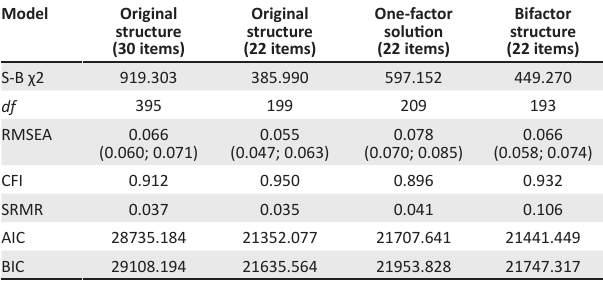
TABLE 2: Goodness-of-fit statistics (Sample 2, n = 308). Model